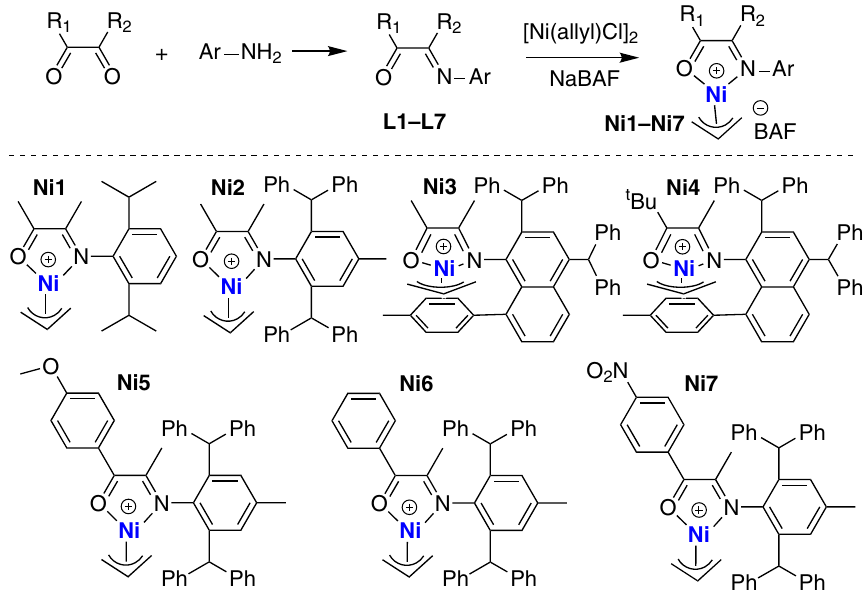
Fig. 2 Synthesis of α -imino-ketone ligands and the corresponding nickel complexes. Reactions of diketone with anilines form α -imino-ketone ligands ( L1 – L7 ). Reactions the ligands with [Ni(allyl)Cl] 2 and NaBAF form the desired cationic nickel complexes ( Ni1 – Ni7